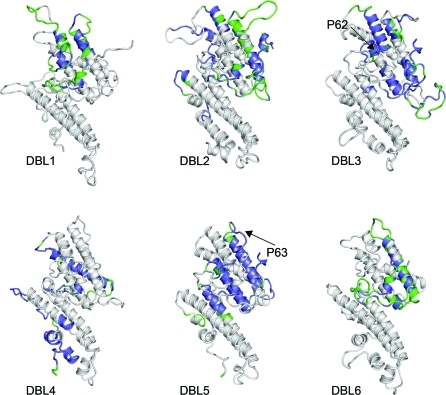
Areas Predicted to be Targeted by Surface-Reactive Antibodies on the Six VAR2CSA DBL DomainsThe highlighted regions were defined on the basis of the results of several experiments where anti-VAR2CSA antibody containing plasma was incubated with parasites expressing native VAR2CSA. Residues with consensus DVs > 1 which are conserved in sequences of VAR2CSA are highlighted in blue, and variable residues with consensus DVs>1 are highlighted in green. See text for details. The positions of DBL3 and DBL5 peptides (P62 and P63 respectively) used for affinity purifying IgG (see Figure 8) are marked with black arrows.